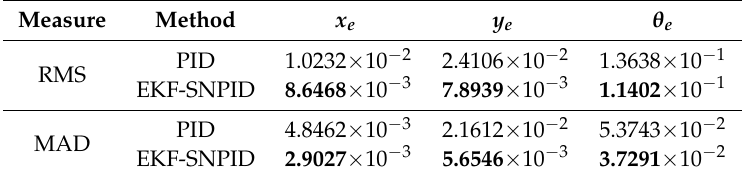
Table 3. Experimental results for the sinusoidal trajectory. The best results are highlighted in